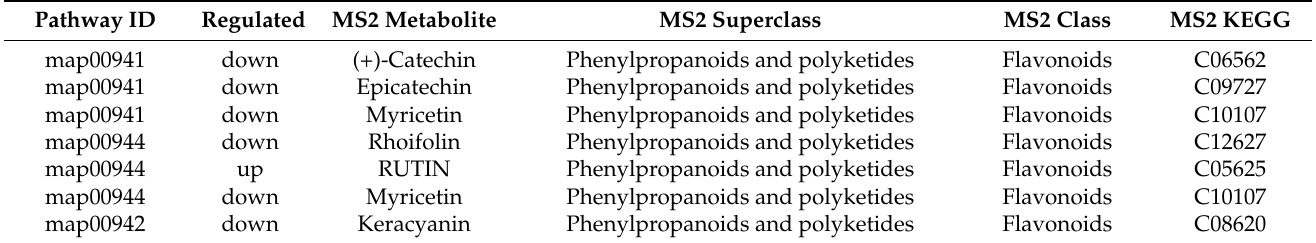
Table 2. Omics data integration of transcriptome and metabolome yielded DEMs in anthocyanin, flavonoid, and flavone and flavanol biosynthesis